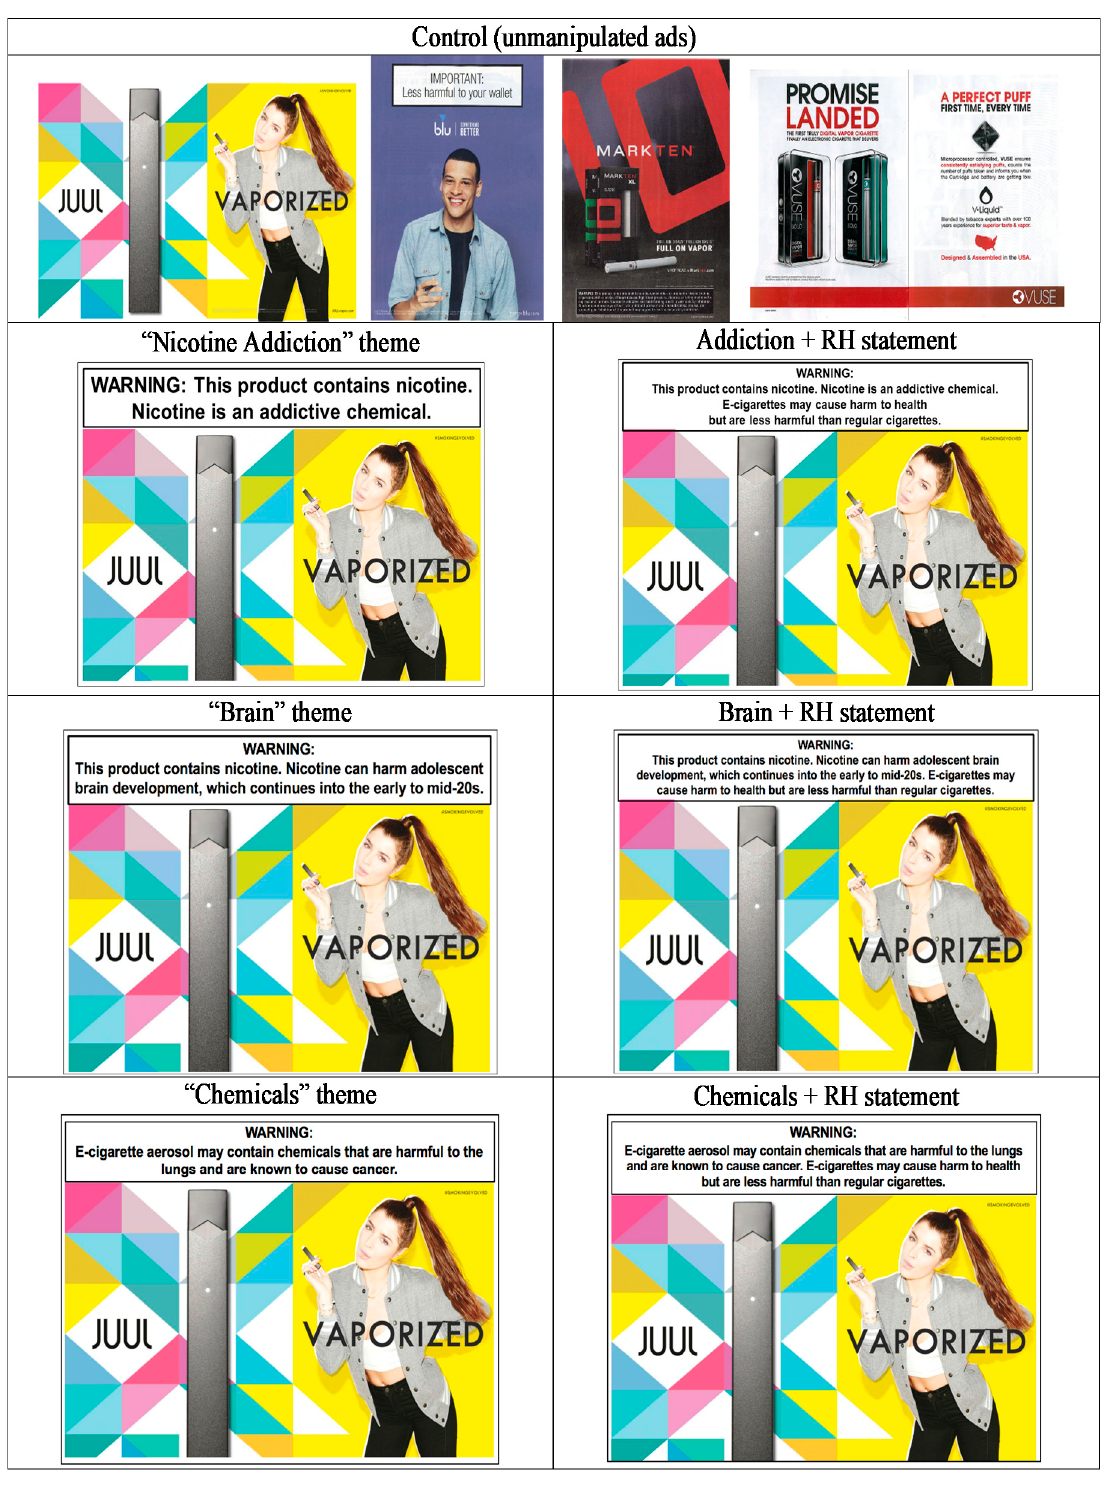
Figure A1. Manipulation of stimuli ads, by condition. NOTE: All four e-cigarette brand ads were viewed in each condition, each containing the same warning, respectively.